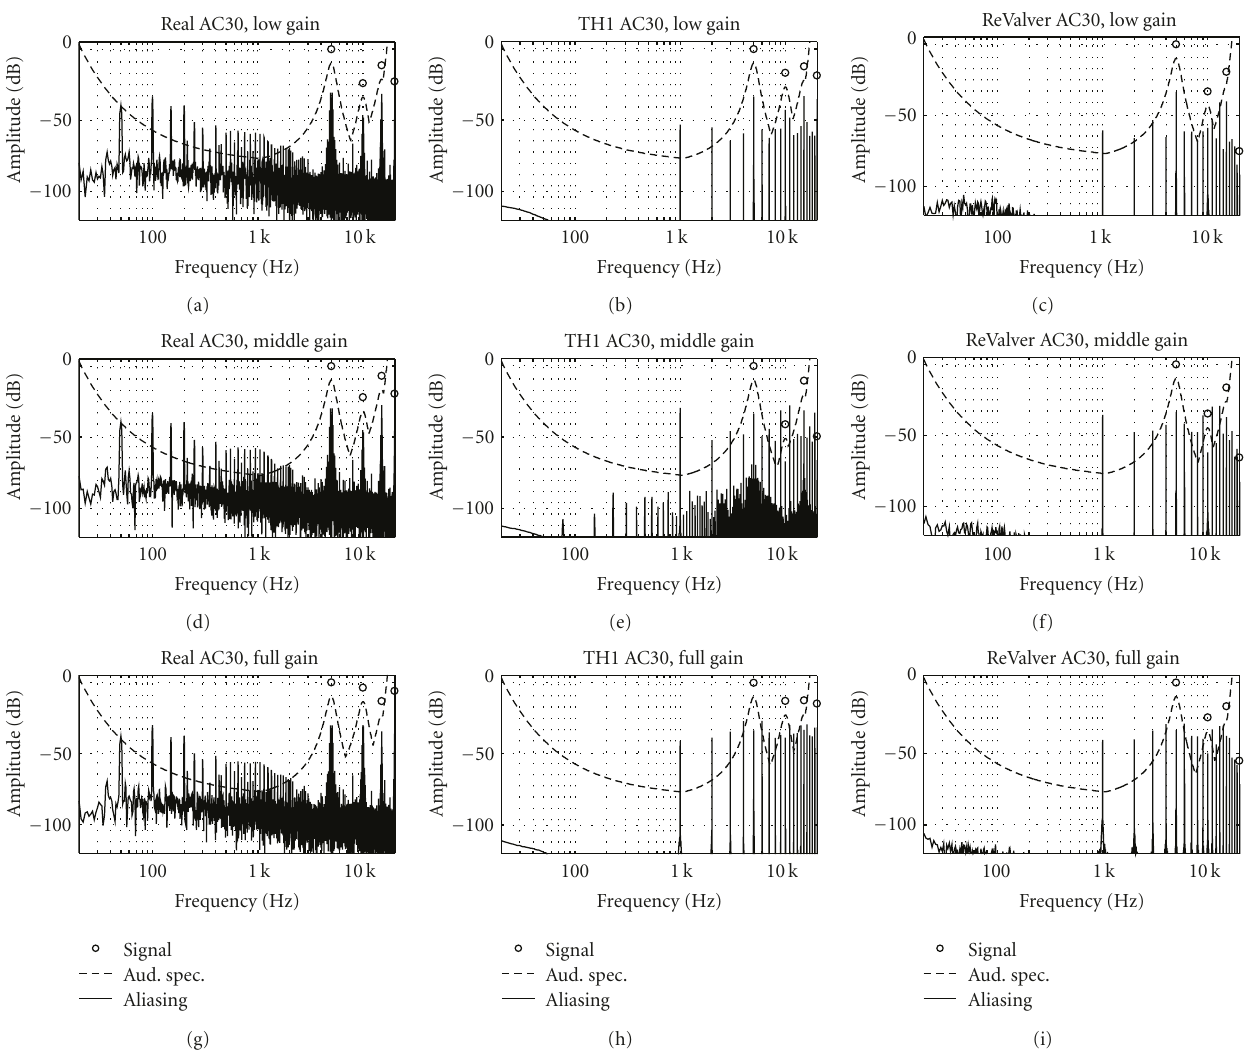
Figure 9: Aliasing analysis for the real AC30 (left column), the TH1 AC30 (middle column), and the ReValver AC30 (right column), when a 5kHz sine is used as input. The gain knob was first set to 9 o’clock (top row), then to 12 o’clock (middle row), and finally to full (bottom row). In the figures, the circles denote the peaks of the harmonic components, while the solid line stands for aliased signal components and noise. The dashed line illustrates an auditory spectrum estimate. In both software plugins (middle and right column), the aliased components greatly exceed the estimated auditory threshold, thus suggesting that the aliasing is clearly audible. For the real AC30 (left column), the figures show that the 50Hz power supply hum and its harmonics are also